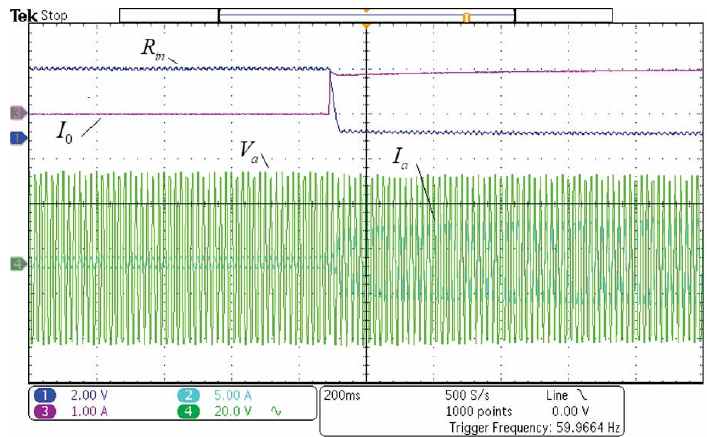
Figure 15. R in controller (5 Ω /V) (2 V/div), dc-link current (1 A/div), grid voltage (20 V/div) and phase current (5 A/div) for PWM rectifier transient from no -load to high -load. Hor. 40